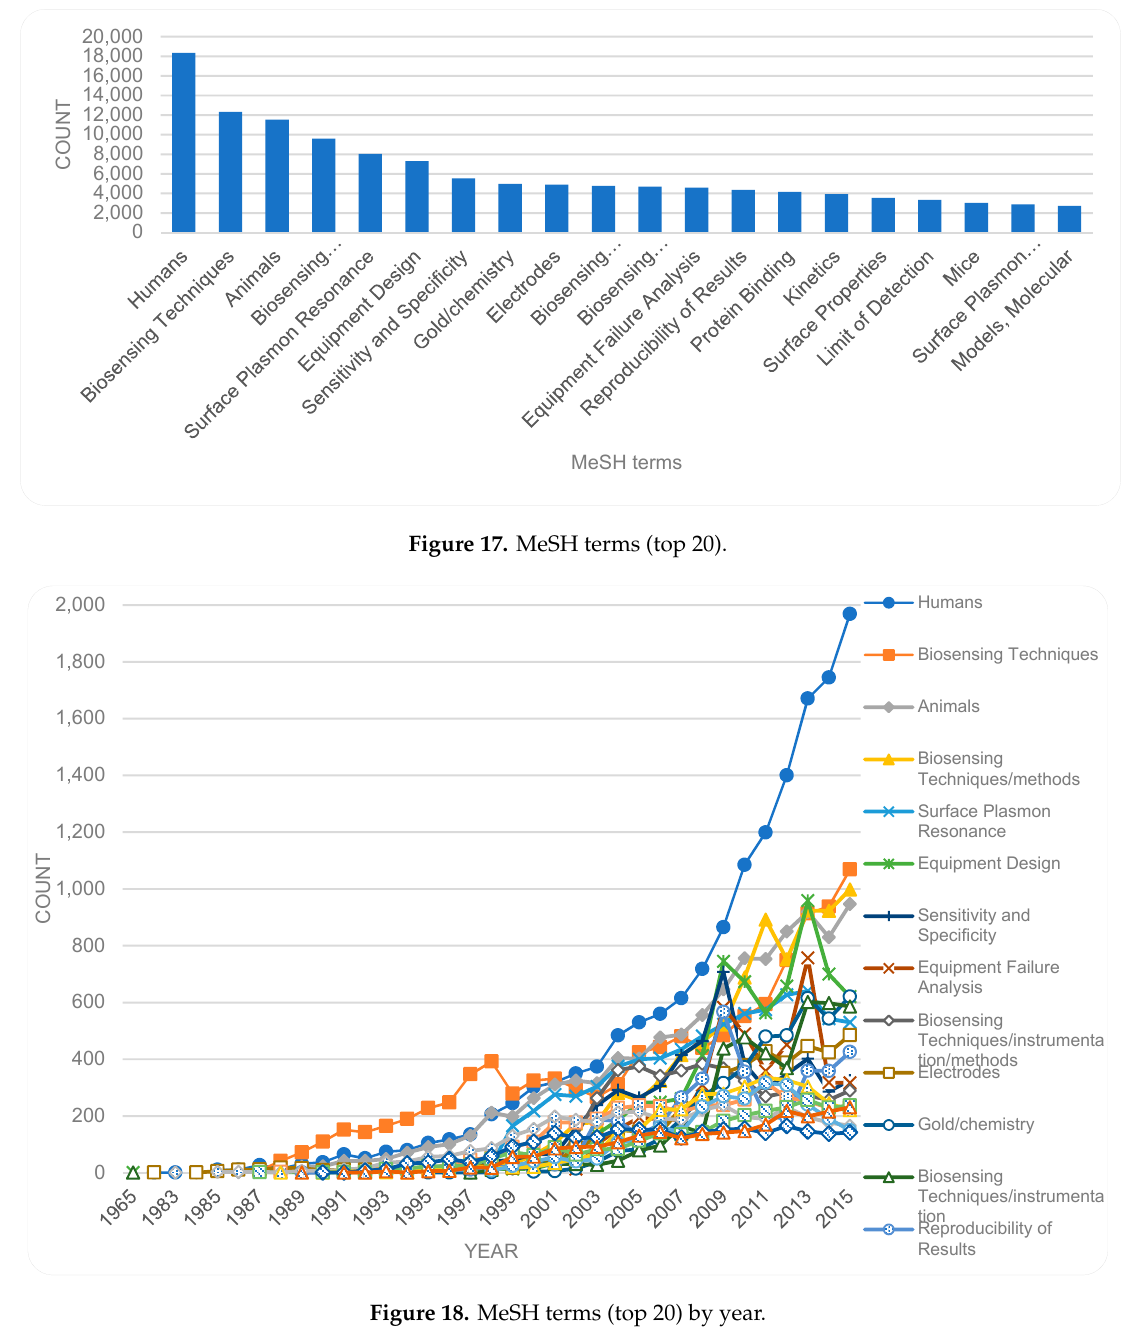
Figure 18. MeSH terms (top 20) by year.